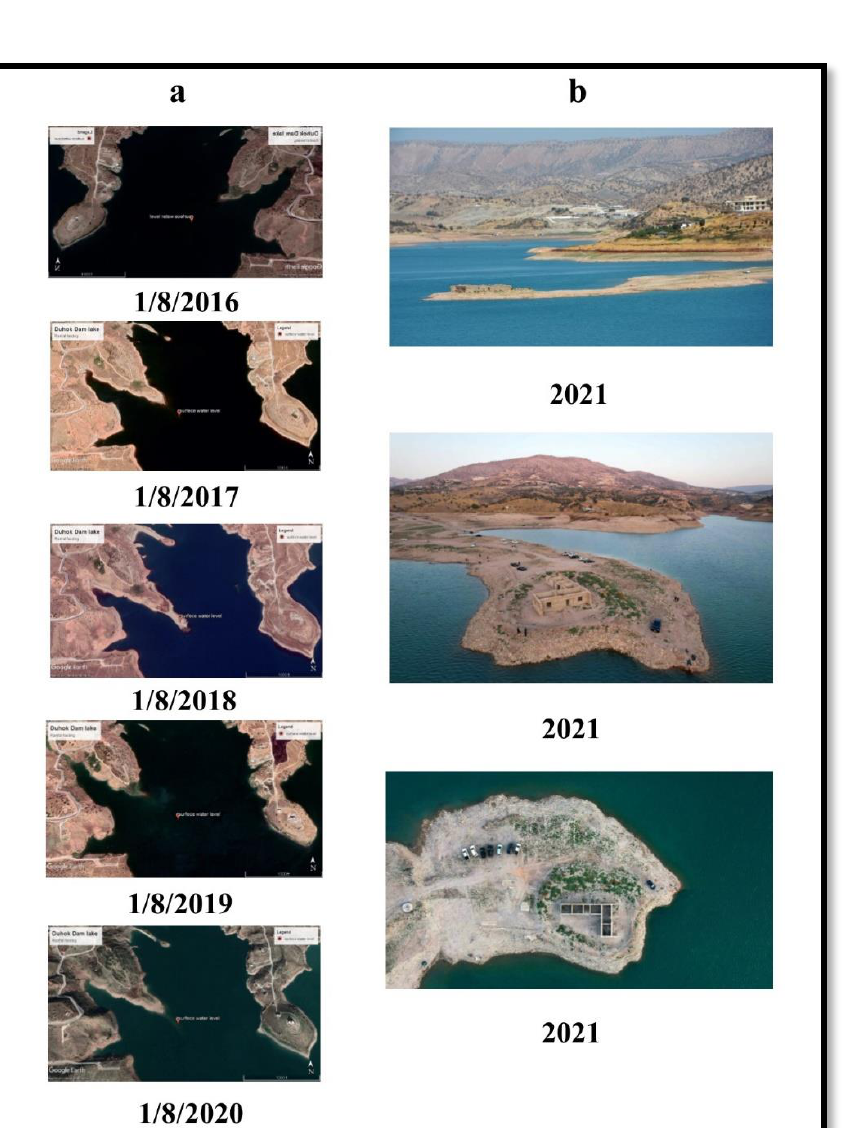
Figure 9. Duhok dam level for dry season during